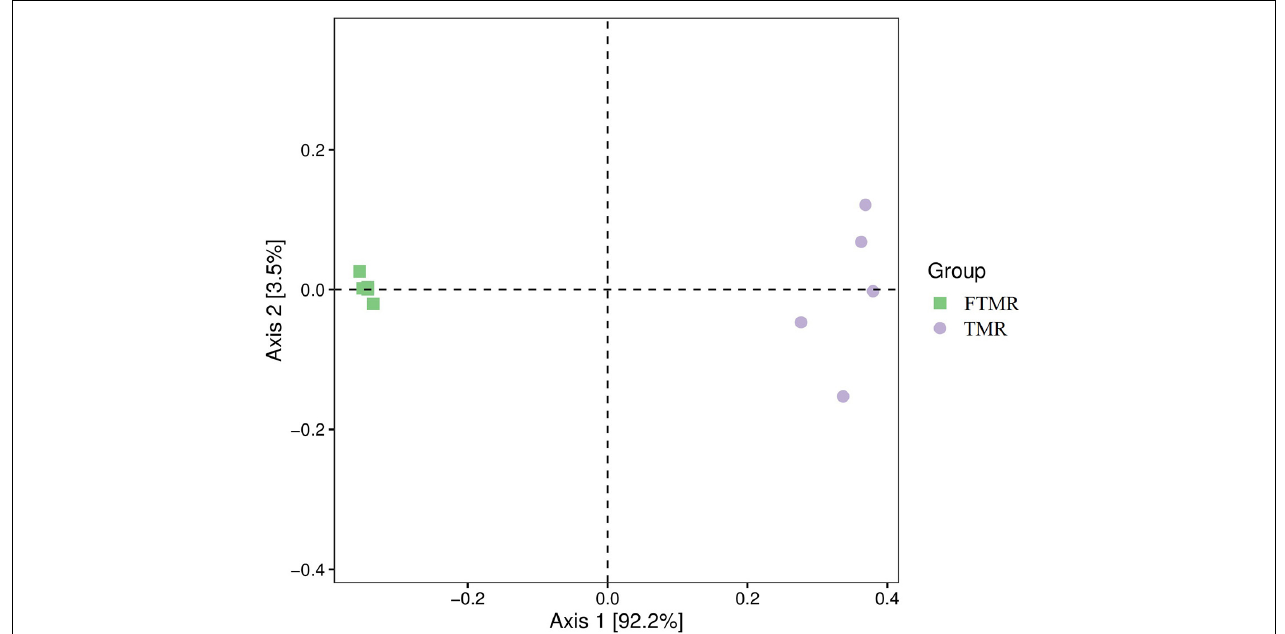
FIGURE 2 | Principal Co-ordinates analysis of the bacterial community in fermented or non-fermented TMR.